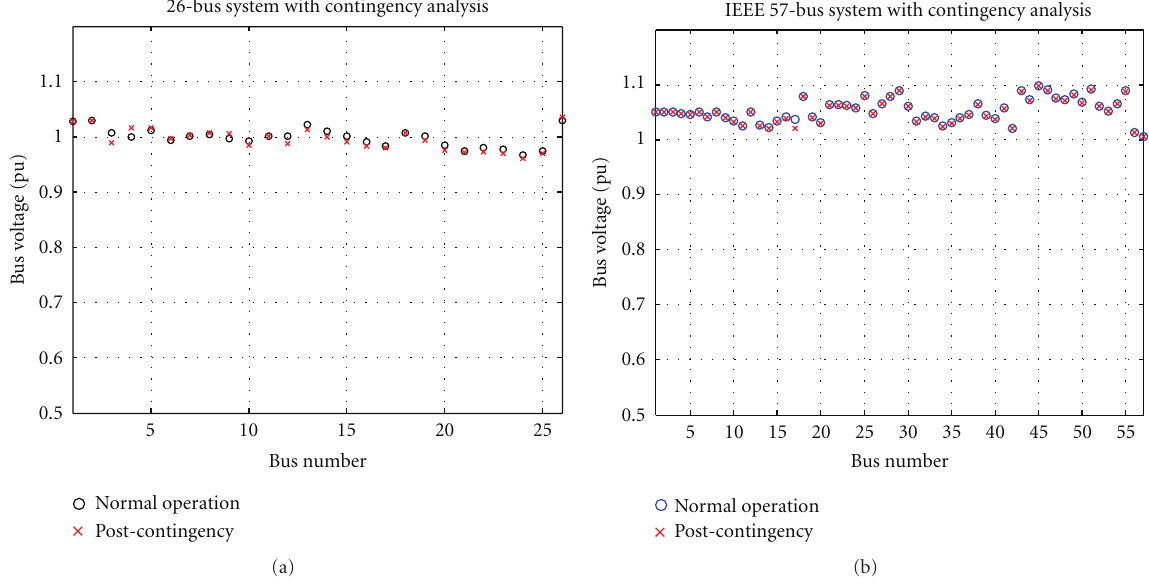
Figure 7: Bus voltage profiles of study systems. (a) Bus voltage profile of system in 26-bus system. (b) Bus voltage profile of system in IEEE 57-bus